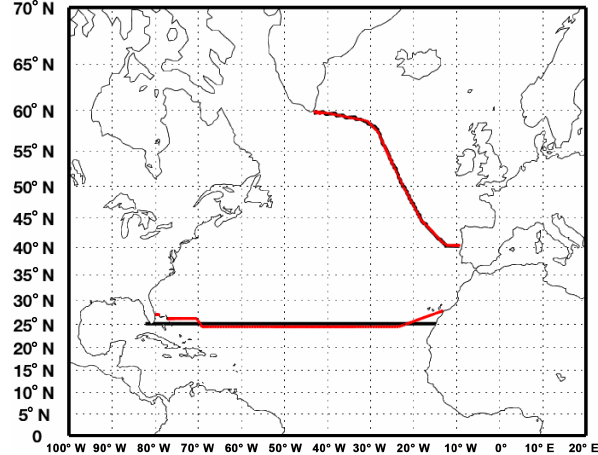
Figure 2. Locations of the 24.5 ◦ N and OVIDE sections in ORCA05–PISCES (black thick line) and observations (red